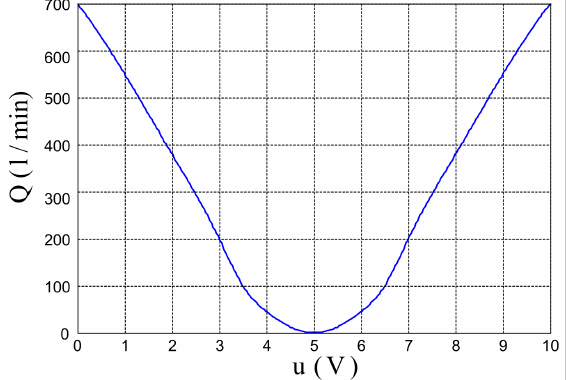
Figure 3. The characteristic curve for the valve flow